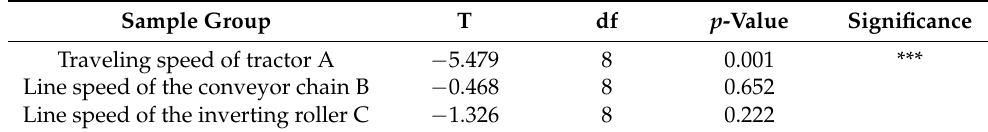
Table 10. Paired sample